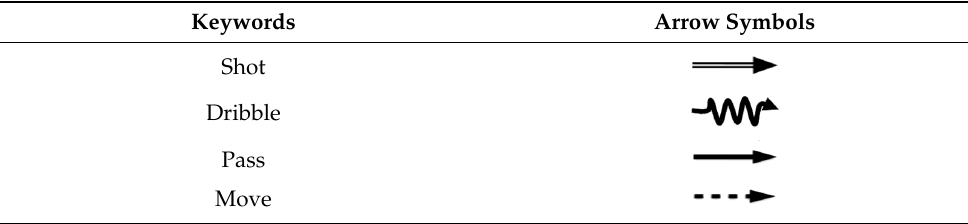
Table 1. Keywords and their corresponding arrow symbols used to depict game actions in soccer. Keywords